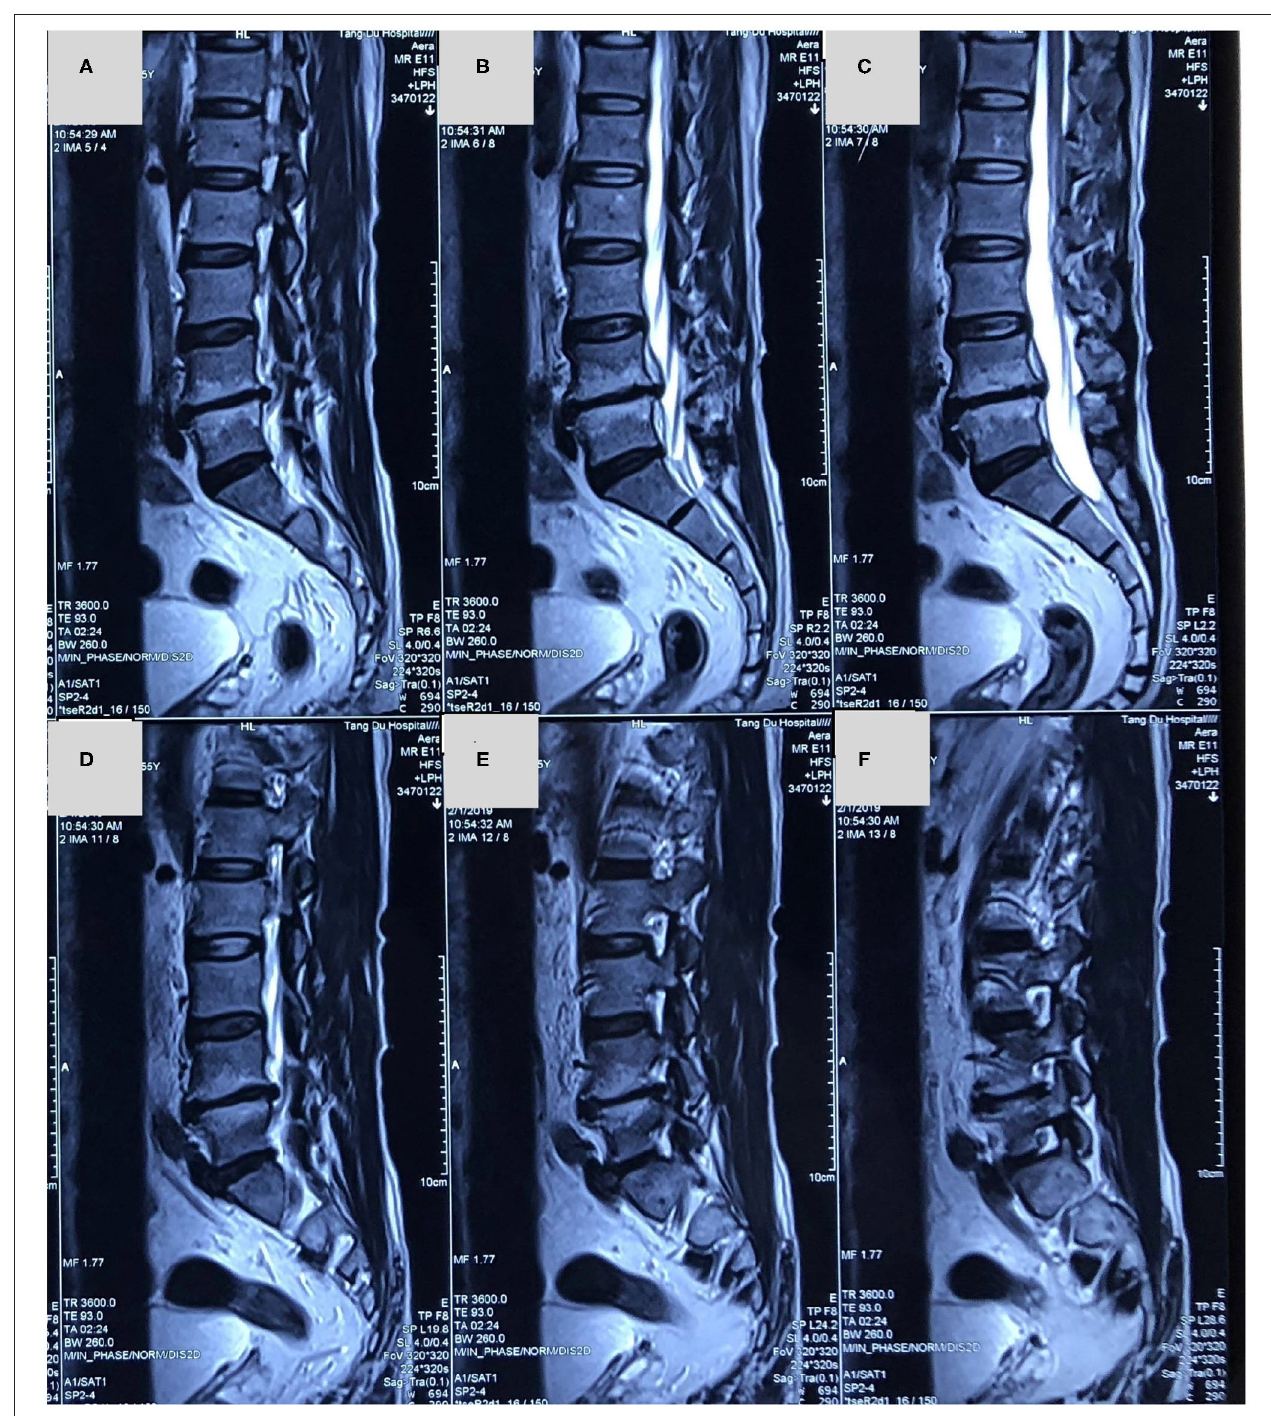
FIGURE 2 | (A–F) A magnetic resonance imaging in sagittal slices showed that lumbar disc herniation in L4/5 segment and L4/5 intervertebral disc was in a condition of Modic II type degeneration.